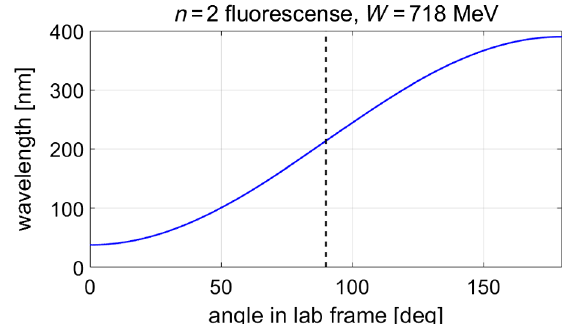
FIG. 3. Dependence of the luminescence wavelength in the laboratory frame of reference upon the detection direction angle. The dashed line shows the PMT angle of view during the